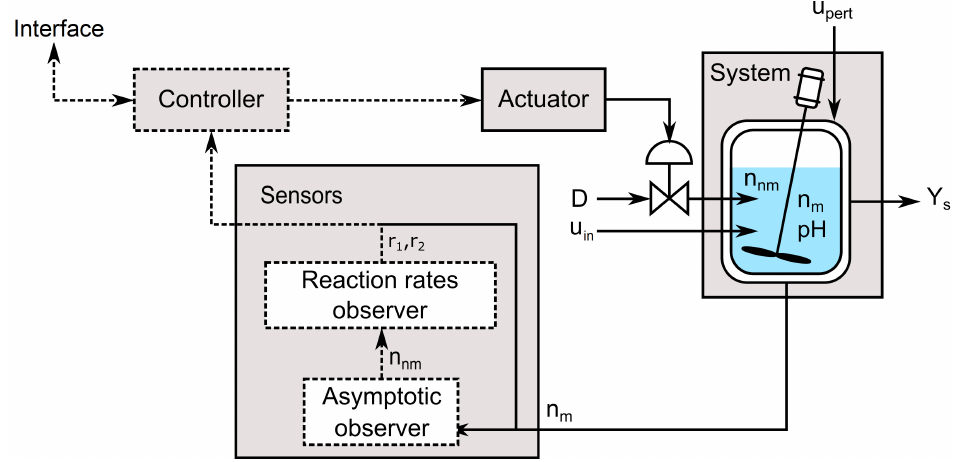
Figure 1. The controller and the observer structure proposed for the anaerobic